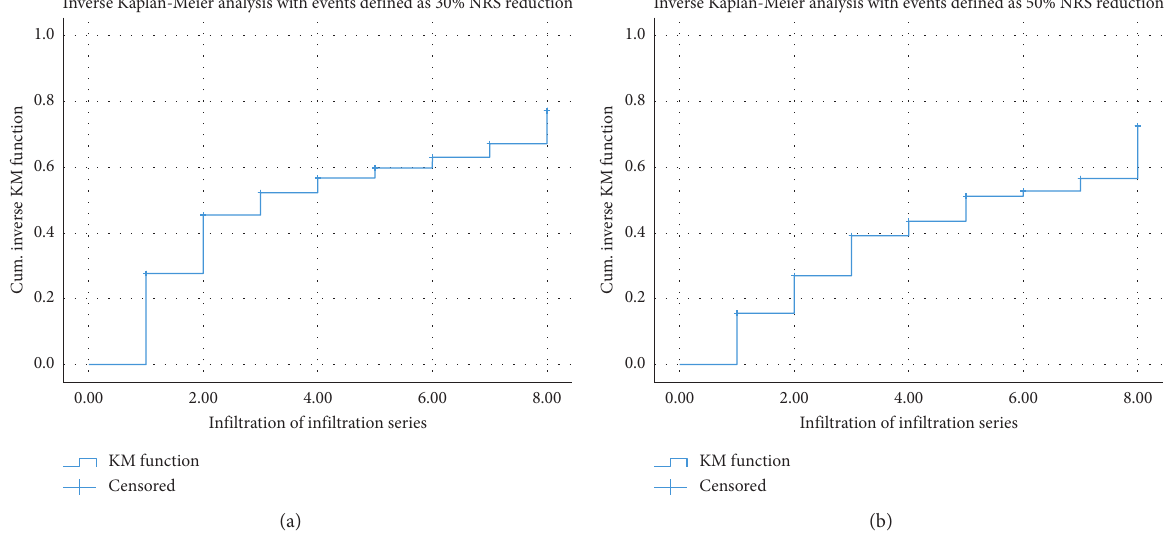
Figure 3: Inverse Kaplan–Meier analysis. (a) Inverse Kaplan–Meier curve with events defined as accomplishment of 30% reduction of initial NRS score. N � 83; event N � 55 (66.3%). (b) Inverse Kaplan–Meier curve with events defined as accomplishment of 50% reduction of the initial NRS score. N � 83; event N � 49